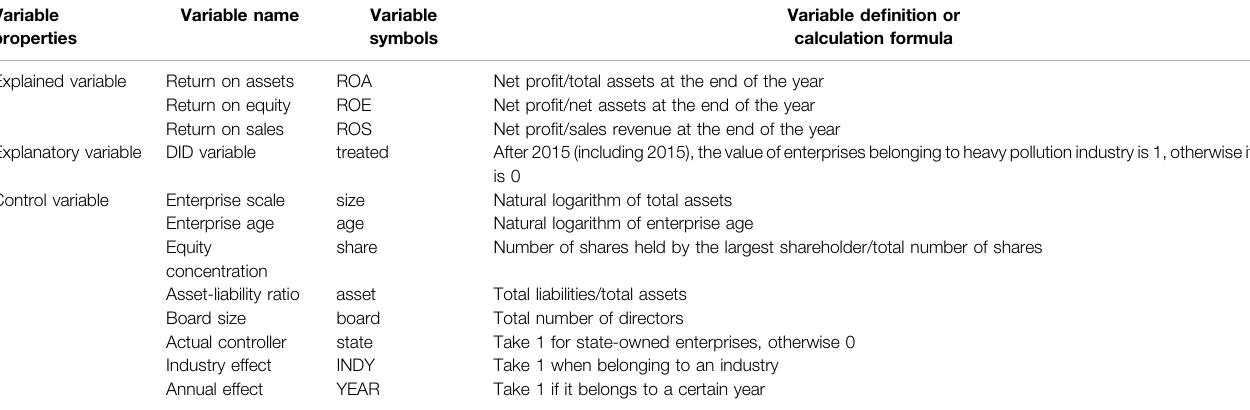
TABLE 1 | Main variables and calculation method. Variable